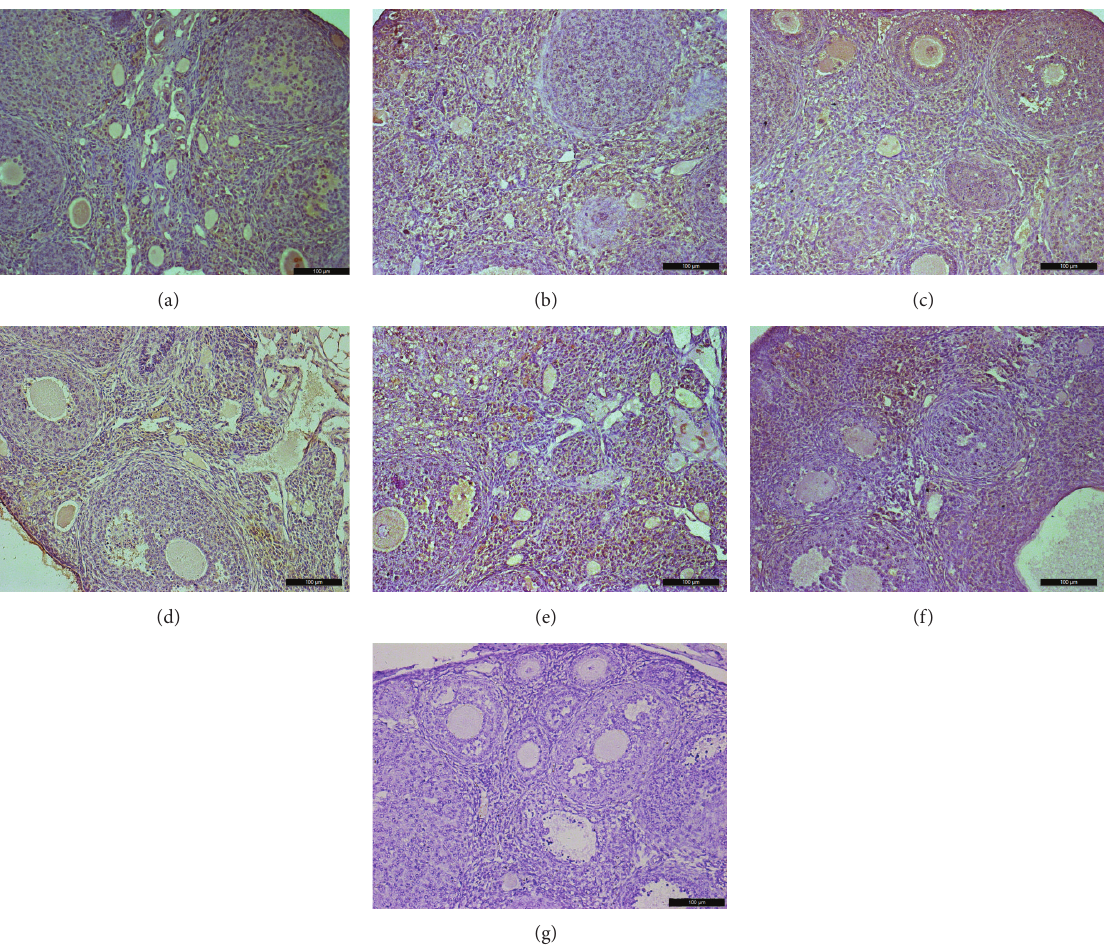
Figure 8: Immunohistochemical analysis for VEGFA expression in mice ovaries of different groups 2 weeks after treatment; ovarian sections with no primary antibody were served as negative controls. (a) control group; (b) Bu/Cy administrated group; (c) Bu/Cy + hAECs (24h) group; (d) Bu/Cy + hAECs-CM (24h) group; (e) Bu/Cy + hAECs (7 d) group; (f) Bu/Cy + hAECs-CM (7d) group; (g) negative control. Scale bar: 100 𝜇